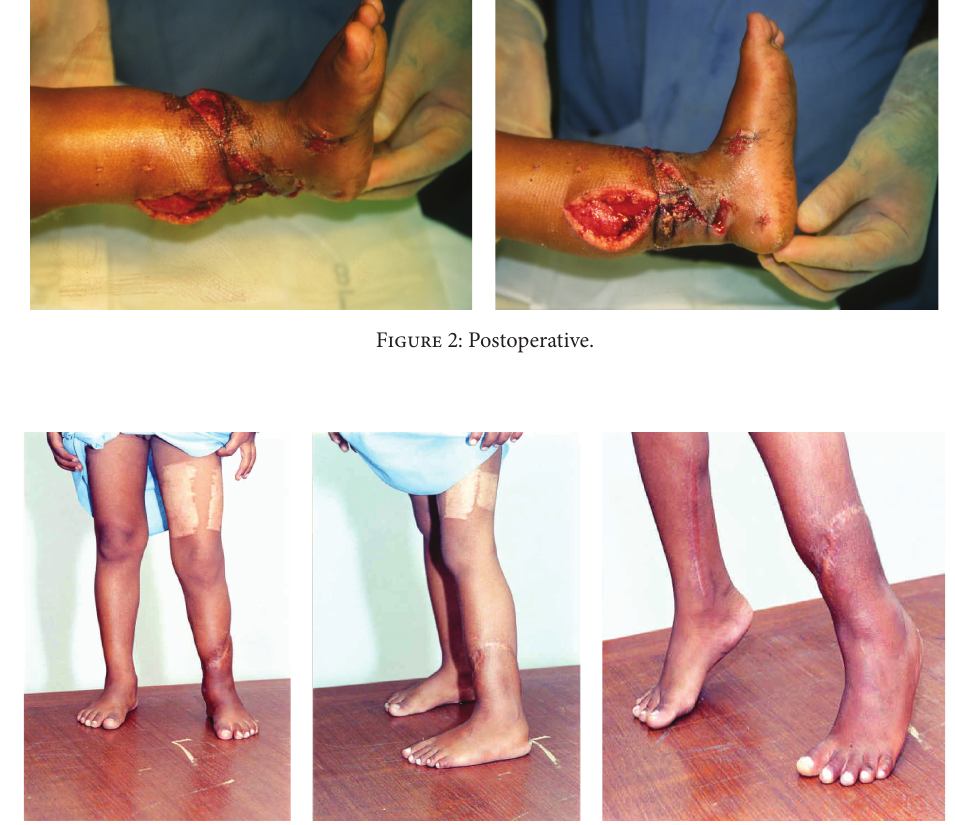
Figure 3: 6-month